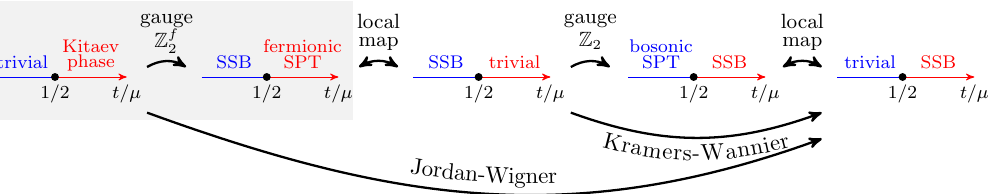
Figure 3: Relations between the gauged and ungauged Kitaev chains and Ising mod- els for h = 0. The Kitaev chain (left) can be gauged by following the procedure outlined in section 3.2. The resulting Hamiltonian is identified with a TFIM (center) through a local transformation. Yet a different TFIM (right) can be obtained either as the Jordan-Wigner dual of the original Kitaev chain, or as the Kramers-Wannier dual of the aforementioned Ising model (i.e., of the gauged Kitaev